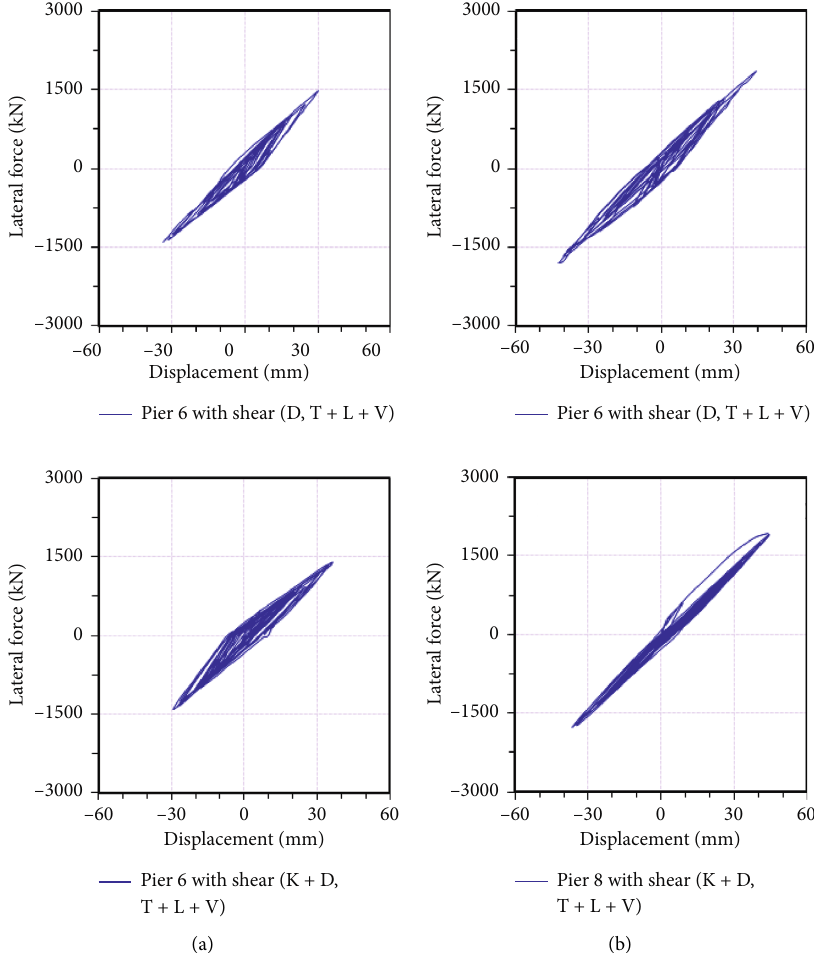
Figure 9: Transverse hysteretic response of the flexure-shear-axial interaction model subjected to triaxial input ground motions of D and K +D earthquakes. (a) Pier 6. (b) Pier